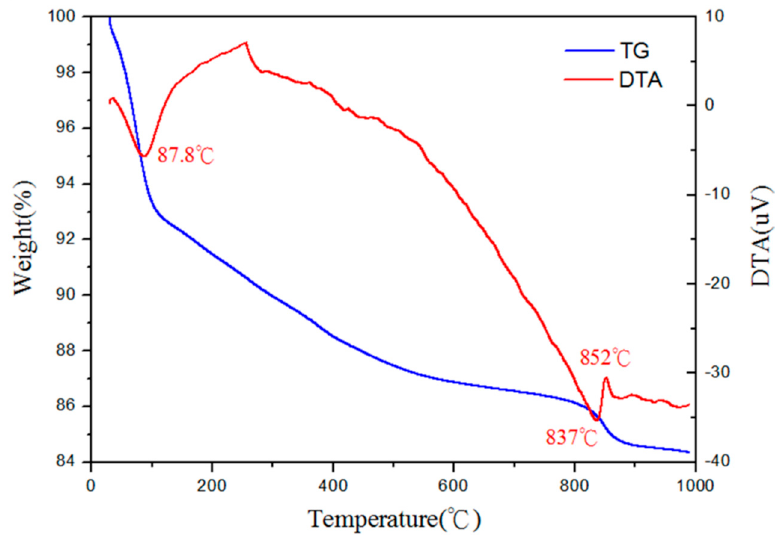
Figure 7. TGA and DTA curves of smectite products synthesized under optimized conditions.